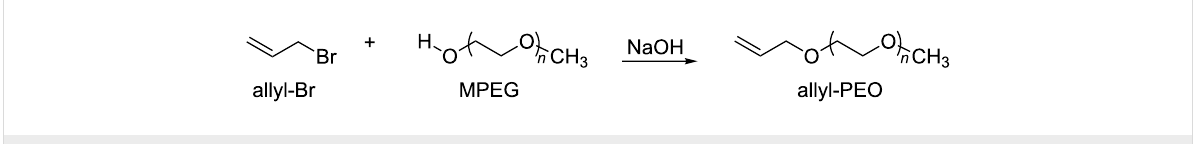
Scheme 1: Equation of the allyl-PEO synthesis reaction.